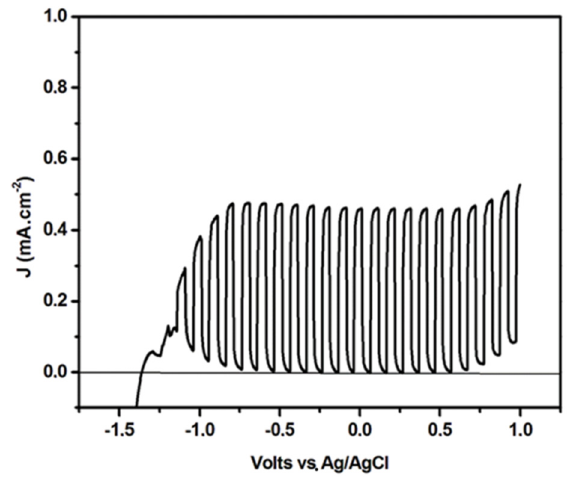
Figure 5. Current density-voltage curves for a photoelectrocatalytic cell made of a (pure) titania photoanode. Recording was done in light chopping mode demonstrating the voltage range of the pure photocurrent. The anodic rise at negative voltages is due to the capacitance current deriving from the adsorption of Na cations from the electrolyte solution [21].